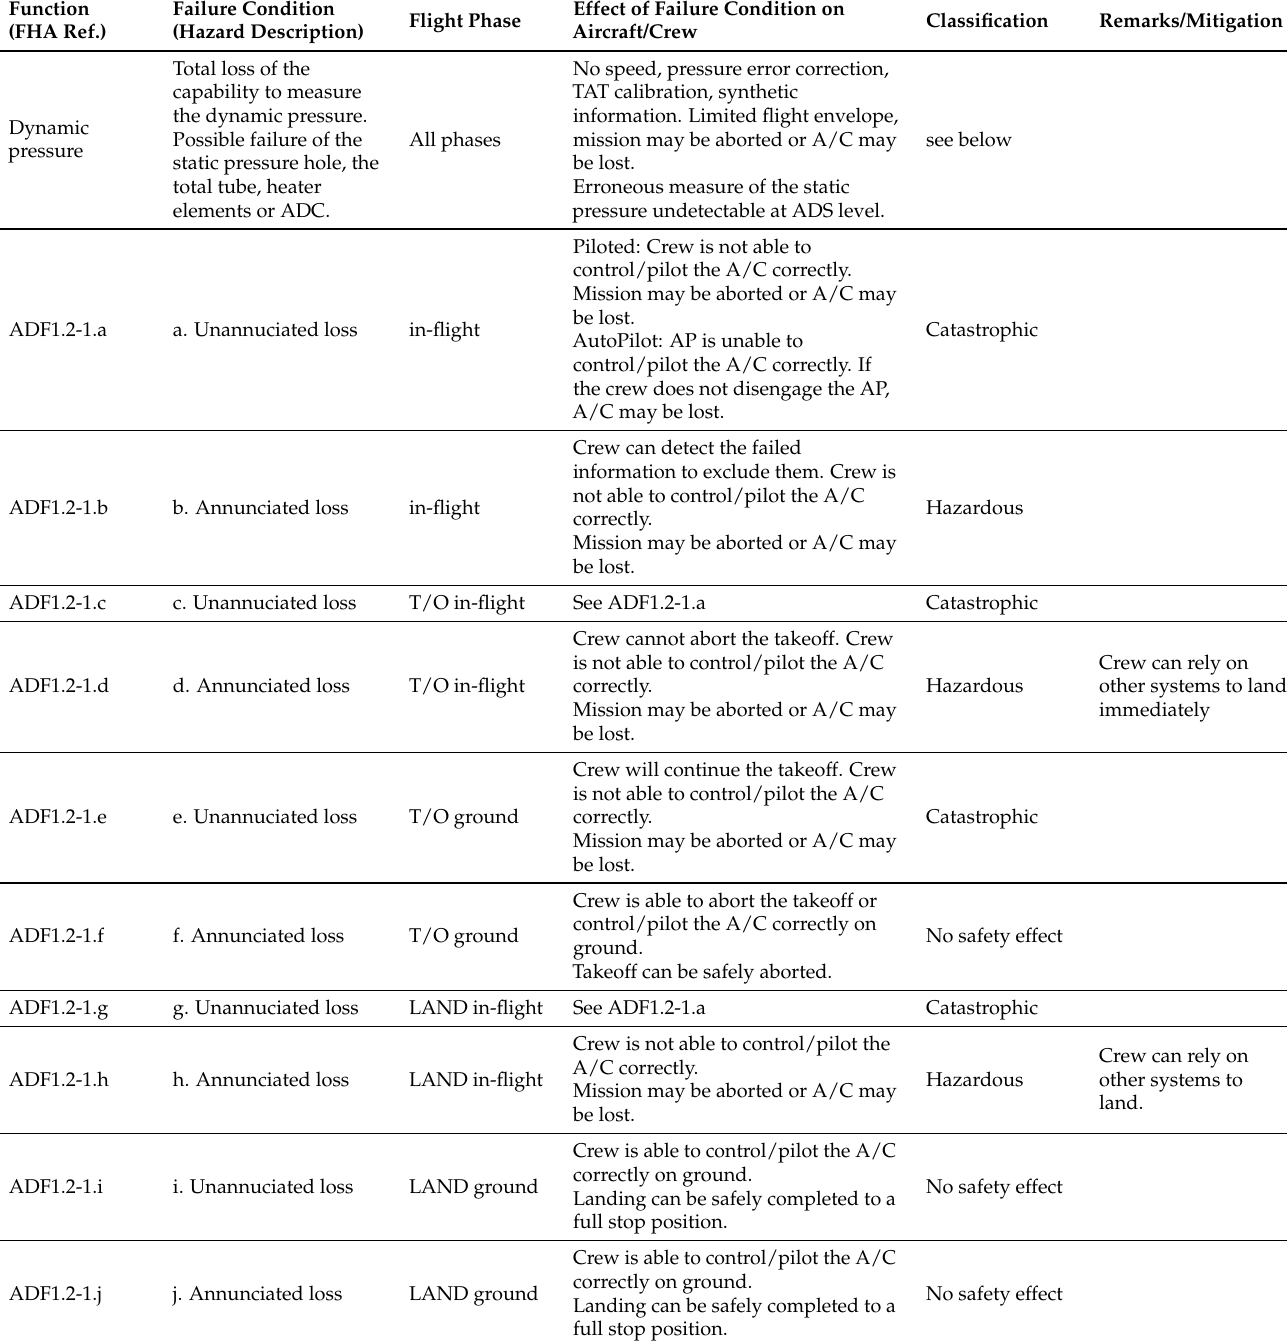
Table A2. ADS FHA for